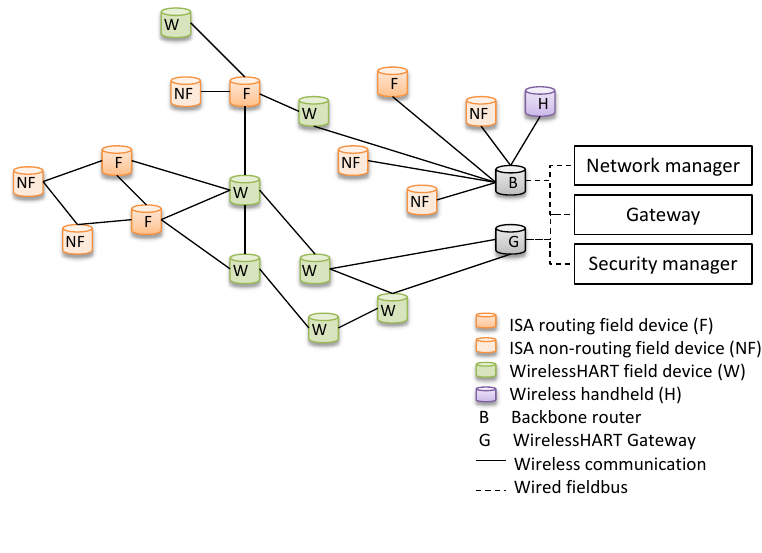
Figure 12. Interoperability of WirelessHART and ISA100.11.a networks